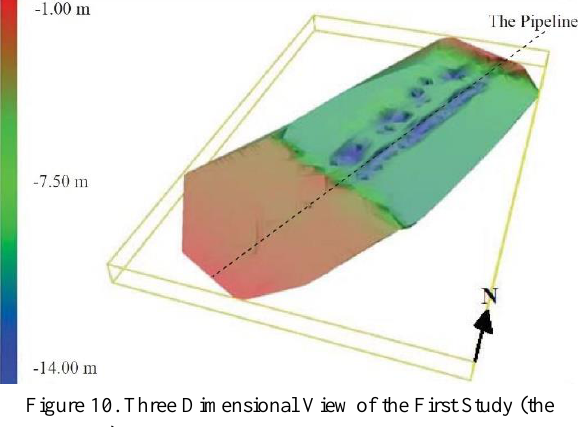
Figure 10. Three Dimensional View of the First Study (the Pipeline) Area Using the Polar Boat's Data on AutoCAD Carlson 5.2 Compare the Data Sets After creating the surface models, the six profiles and